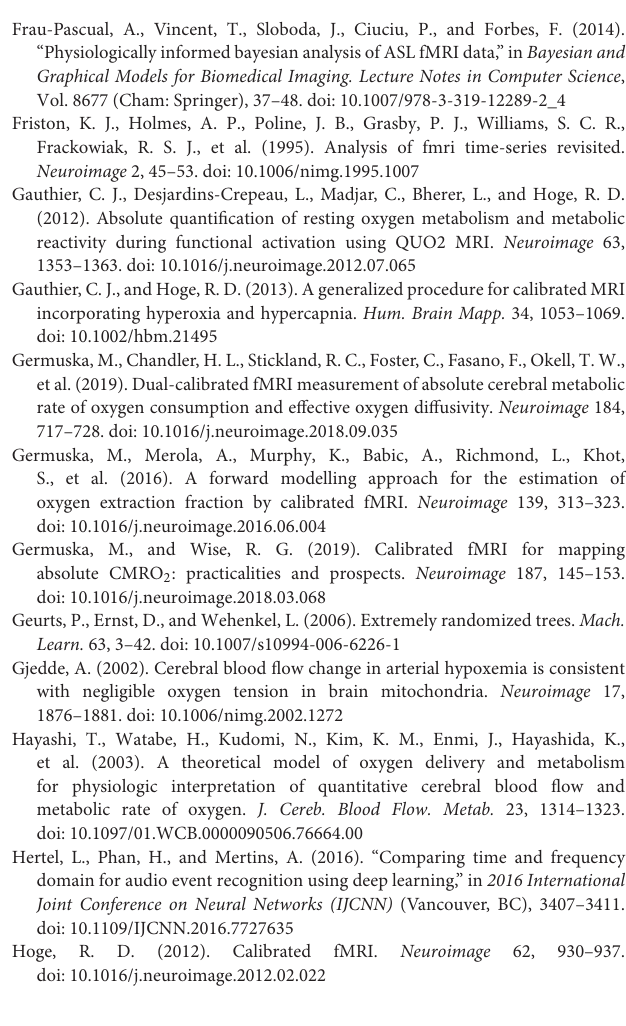
Supplementary Table 1 | Demographic data for healthy